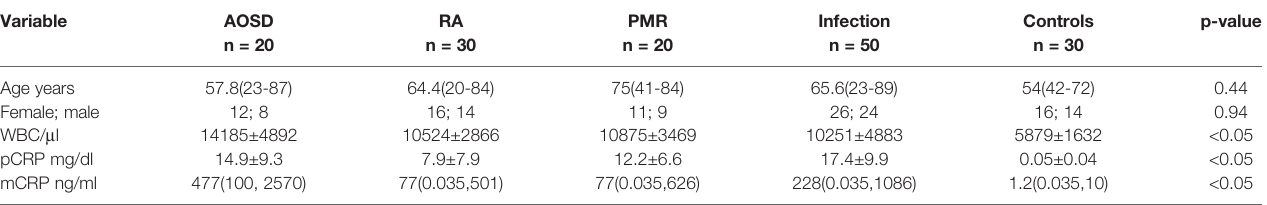
TABLE 1 | Patient